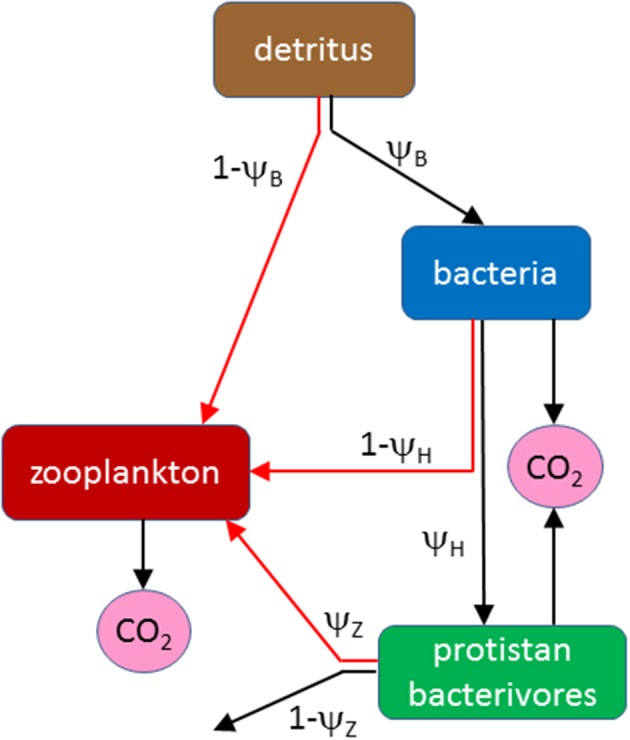
Flow diagram of the model showing pathways of organic matter between detritus, bacteria, protistan bacterivores and zooplankton, as specified by parameters ψB, ψH, and ψZ. Black arrows represent C-only flows, red arrows involve both C and DHA (involving stoichiometric calculations).